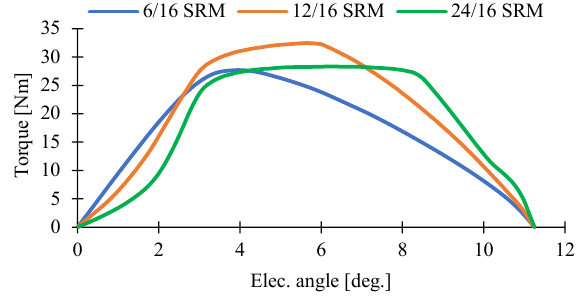
Figure 5. Static electromagnetic torque at a 60 A excitation current for 6/16, 12/16, and 24/16 SRMs. There are various options for the number of rotor poles that would provide a balanced three-phase operation with 12 stator poles. The possible numbers of rotor poles are 8, 16, and 20 [21]. The numbers of torque pulsations for the considered number of rotor poles are 24, 48, and 60, respectively. The main operating speed of the motor is 5450 r/min according to Table 1. The electrical frequencies of the considered numbers of rotor poles at 5450 r/min are 726.67 Hz, 1453.33 Hz, and 1816.7 Hz, respectively. The lower number of torque pulsations can increase the torque ripple and higher electrical frequencies can increase the losses. Moreover, a lower number of rotor poles results in wider stator poles that require thicker stator back-iron. Hence, this reduces the copper fill factor and decreases the torque production capability. A higher number of rotor poles results in higher core loss and narrower stator poles that can over saturate both stator and rotor poles. Figure 6 shows the static electromagnetic torque of 12/8, 12/16, and 12/20 SRMs at a 60 A excitation current. The same MMF is provided for all three SRMs. The outer diameter, stator bore diameter, and stator and rotor pole heights are the same. The average static torque for 12/8, 12/16, and 12/20 SRMs are 17.8 Nm, 20.1 Nm, and 19.1 Nm, respectively. Therefore, the design with 16 rotor poles has a higher torque production capability.